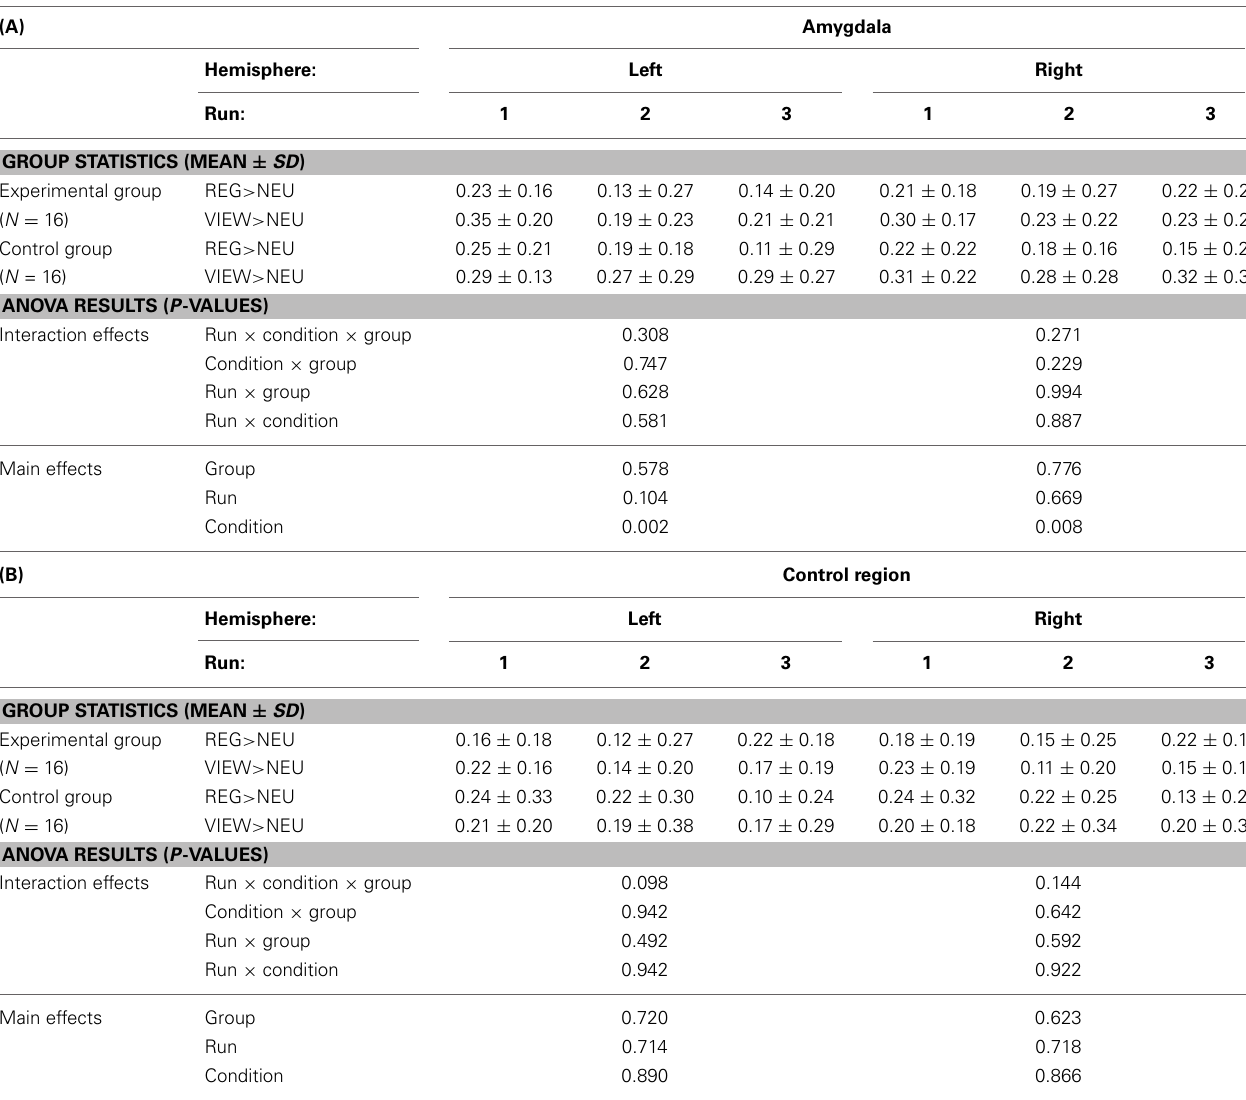
Table 1 | Group statistics and ANOVA results of neurofeedback training. (A)